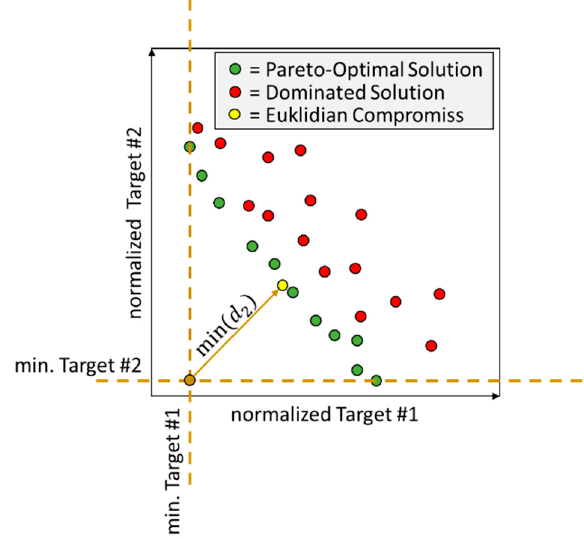
Figure 11. Schematic visualization of the resulting pareto-optimal solutions, including the choice of the solution with the best compromise between the reachable target values.